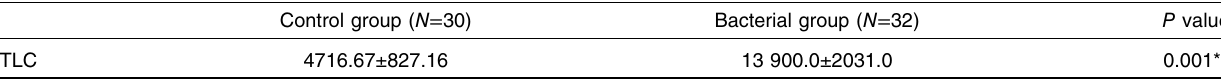
Table 9 Comparison between mean values of TLC in the control and bacterial groups